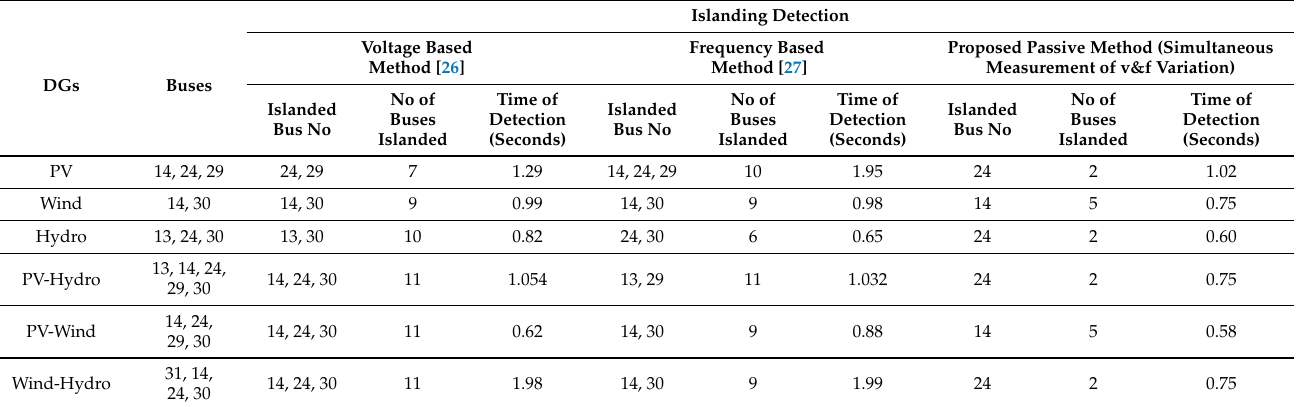
Table 5. Comparison results of islanding detection for the 33 bus